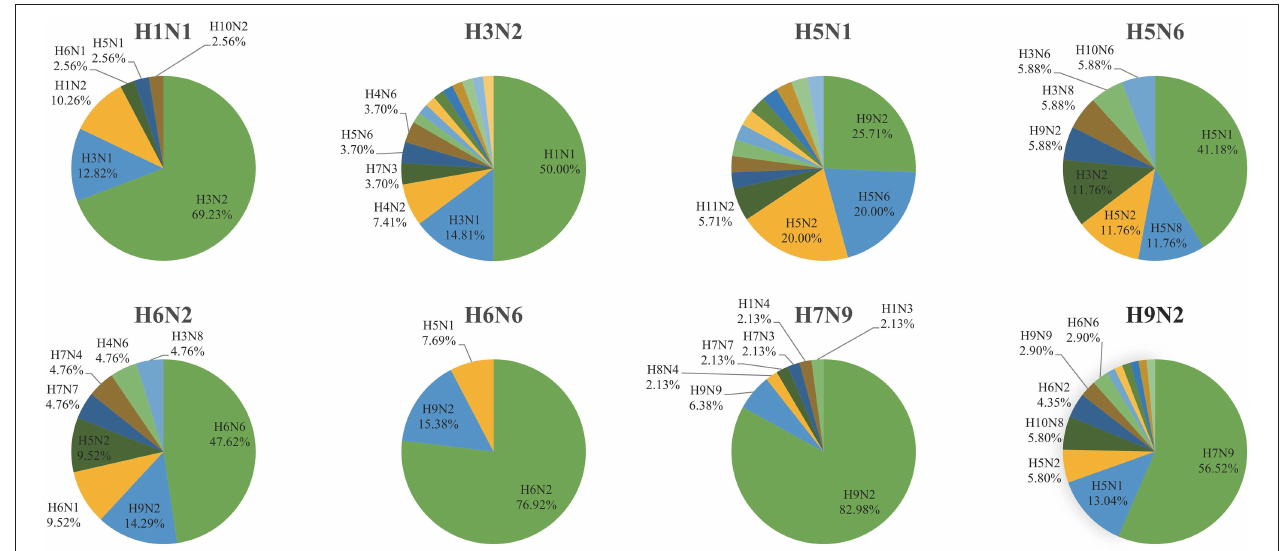
FIGURE 6 | The occurrence frequency of other subtypes in the inter-subtype reassortment event of a specific subtype (H1N1, H3N2, H5N1, H5N6, H6N2, H6N6, H7N9, and H9N2).